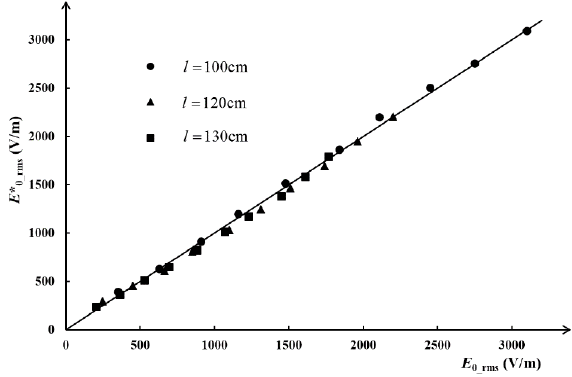
Figure 10. The results in different measuring positions.